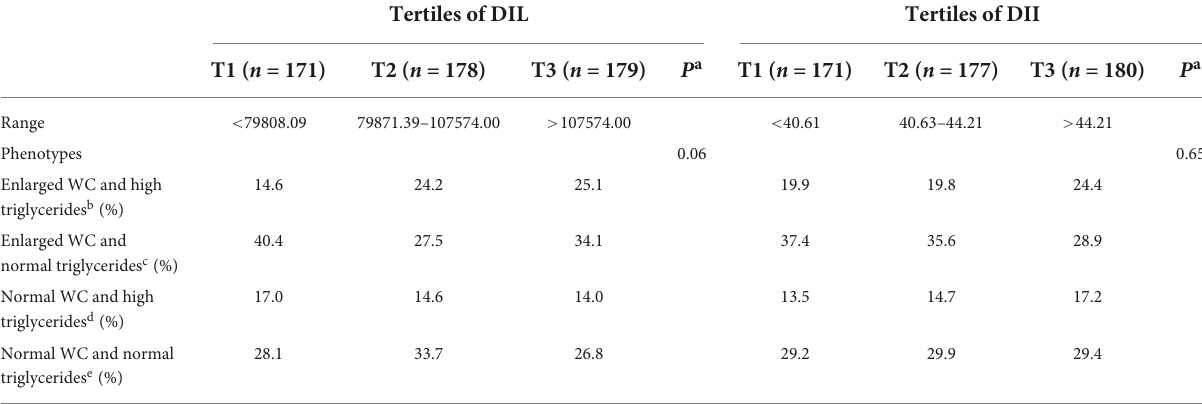
TABLE 3 Distribution of different phenotypes of serum triacylglycerol concentration and waist circumference (WC) across tertiles of DIL and DII. Tertiles of DIL Tertiles of DII